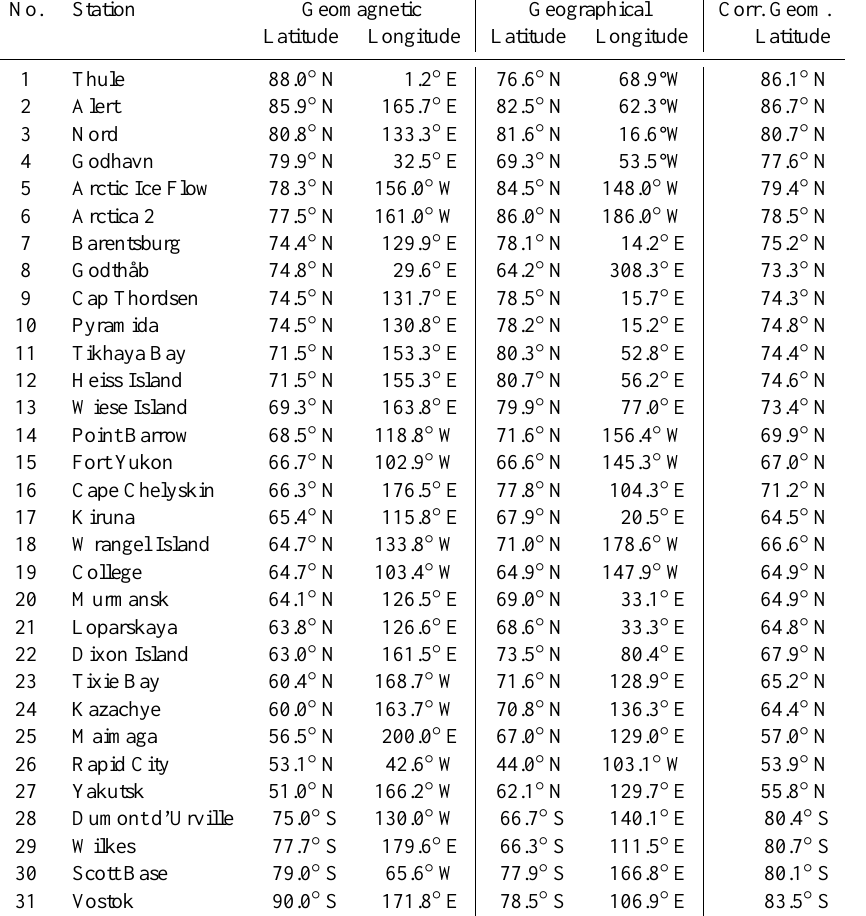
Table A1. Coordinates of stations for the observation of auroral luminosity; the last column indicates Corrected Geomagnetic Latitudes.